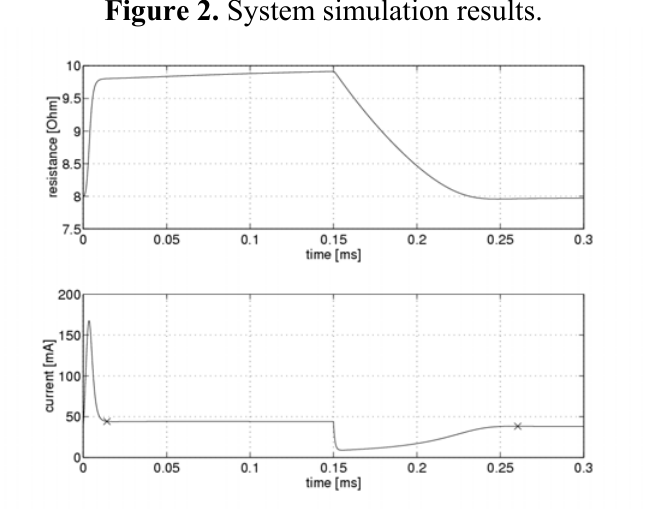
Figure 2. System simulation results.